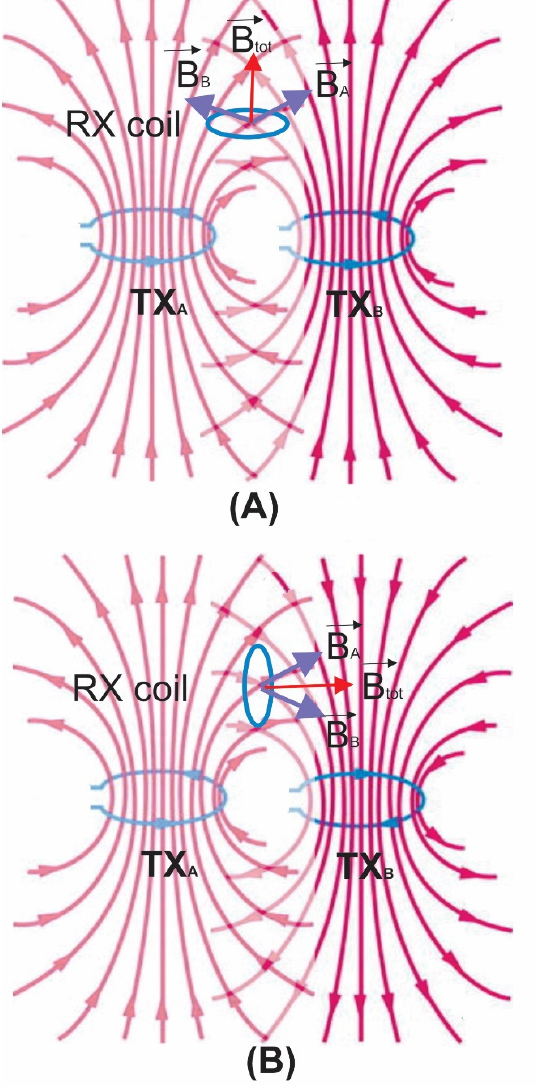
Figure 1. Schematic theory of the resultant vector of the magnetic field at the receiver between two co-excited transmitter coils. Two transmitters are excited in the ( A ) same and ( B ) opposite current directions. The purple arrows show the EM field vector from each loop. The red arrow shows the total